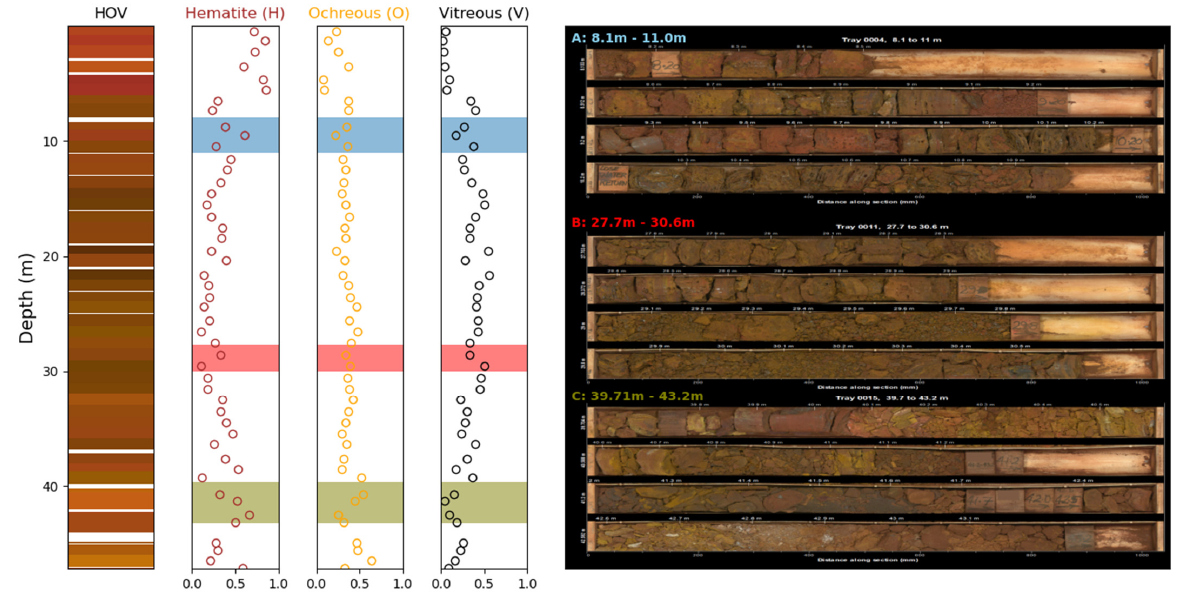
Figure 15. Application of the boomerang methodology to drillcore 3. The first column is a false colour image of the downhole estimated mixing ratios where the RGB values are determined from the relevant endmember mixing ratio and are colored as per the mixing ratio columns (columns 2–4) of hematite (brown), ochreous goethite (orange), and vitreous goethite (black). In columns 2–4 the mixing ratios are averaged over 1 m for the drillcore and coloured by their respective endmember colours. Column 5 shows colour images of the trays at specific locations in the drill core that show the range of ochreous and vitreous goethite and hematite. The depths the core trays span are shown in colored text above each tray with their locations corresponding to the coloured horizontal bar in columns 2–4.